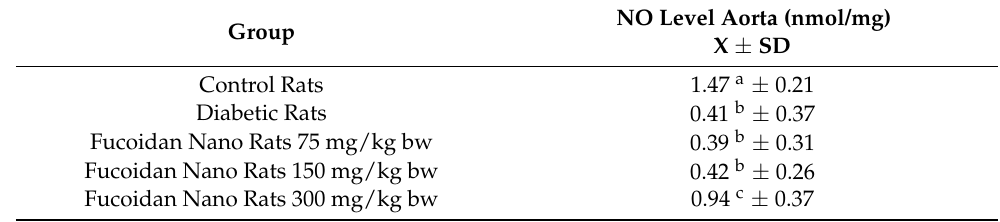
Table 2. Fucoidan nanoparticles effects on NO levels aortic tissue of various treatment.